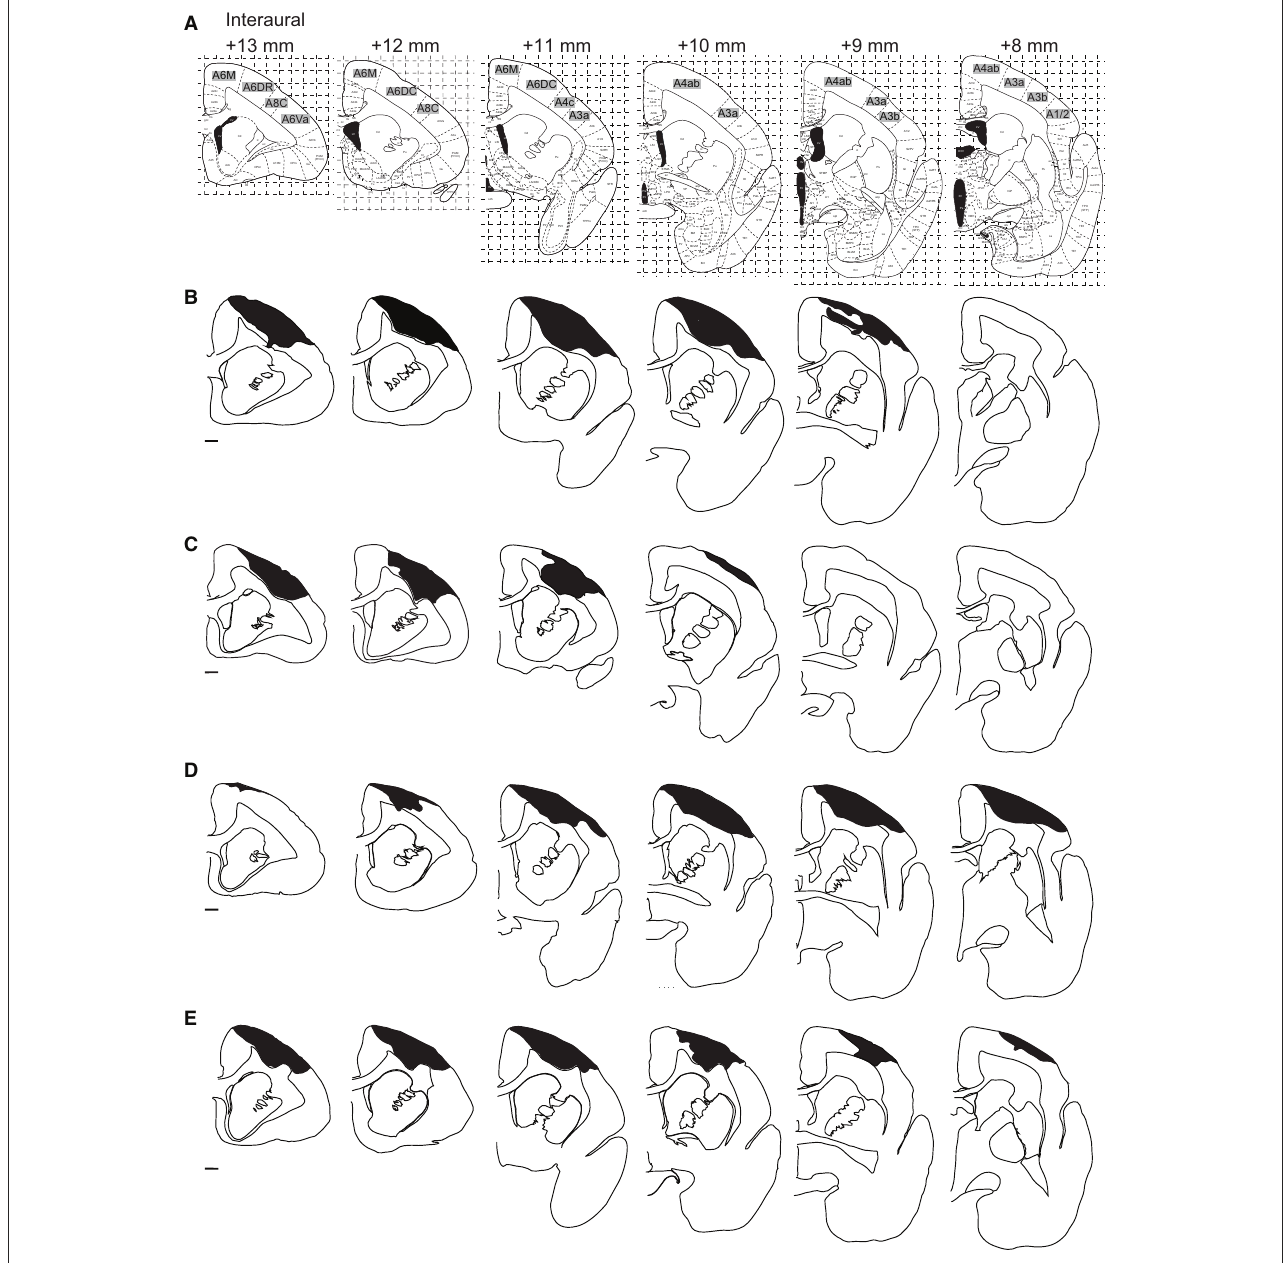
FIGURE3 Distribution of the lesion area. (A) The corresponding coronal sections of the marmoset brain atlas (42). (B–E) Serial coronal sections of the lesion area in Monkey K (B) , Monkey M (C) , Monkey P (D) , and Monkey U (E) . Black hatched areas indicate the lesion area identified by Iba-1 immunostaining. Only the hemispheres ipsilateral to the lesion site are shown at intervals of 1mm. Scale bar,